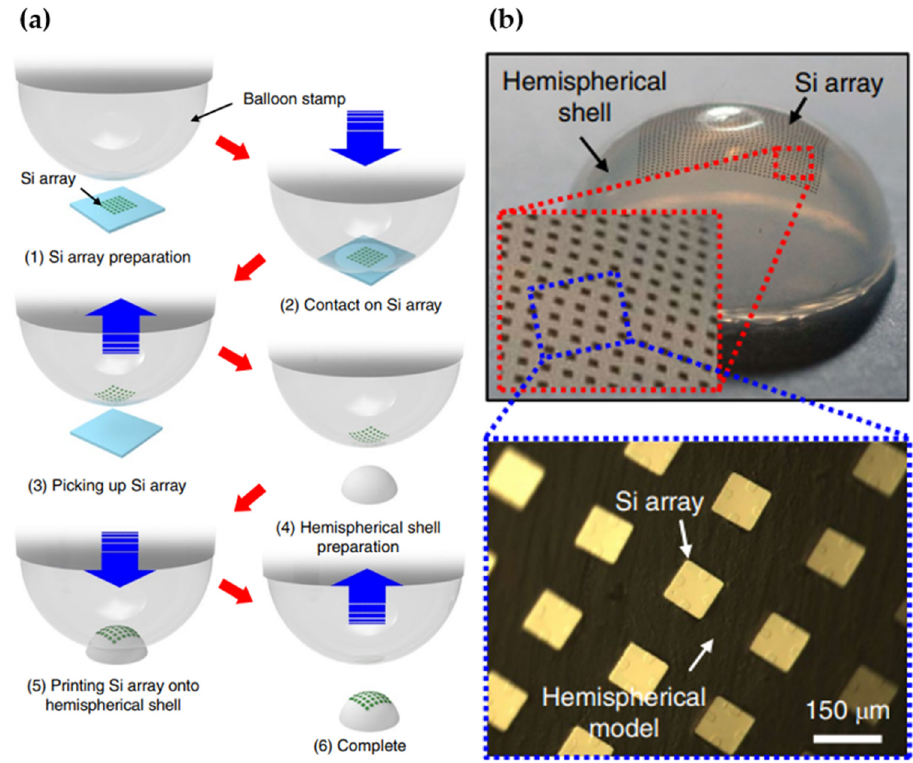
Figure 18 . ( a ) The fabrication process of 3D curved optoelectronics using CAS printing. ( b ) The top image of CAS-printed Si array on a hemispherical shell. Reproduced from [60] with permission from Springer Nature Publishing.